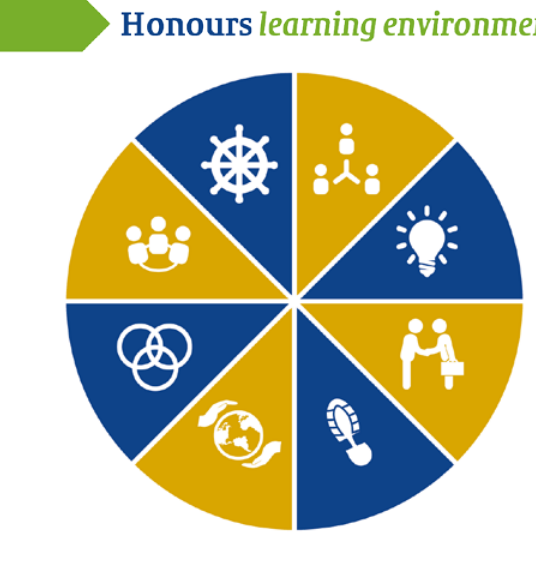
Figure 1: Model Honours learning environment